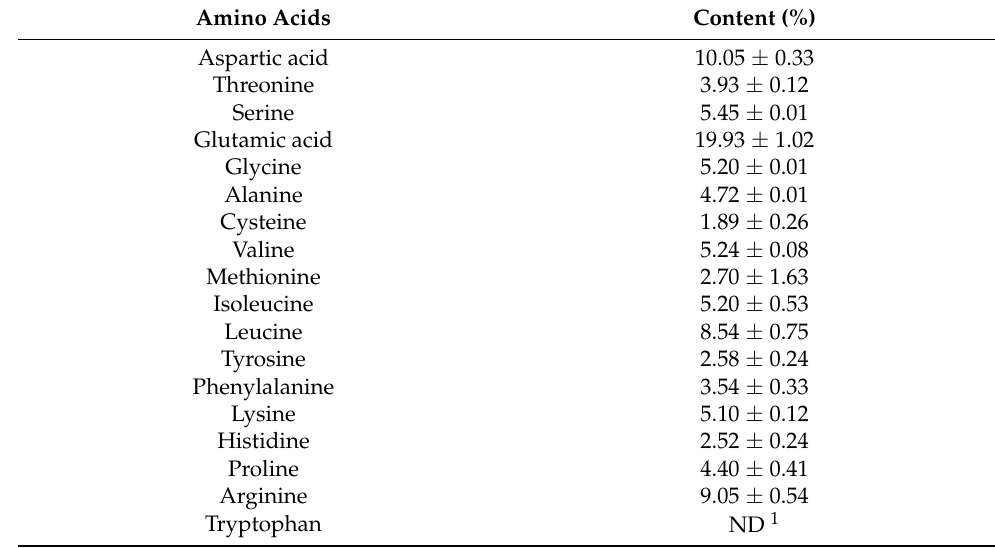
Table 3. The composition in amino acids of the proteins of I. gabonensis